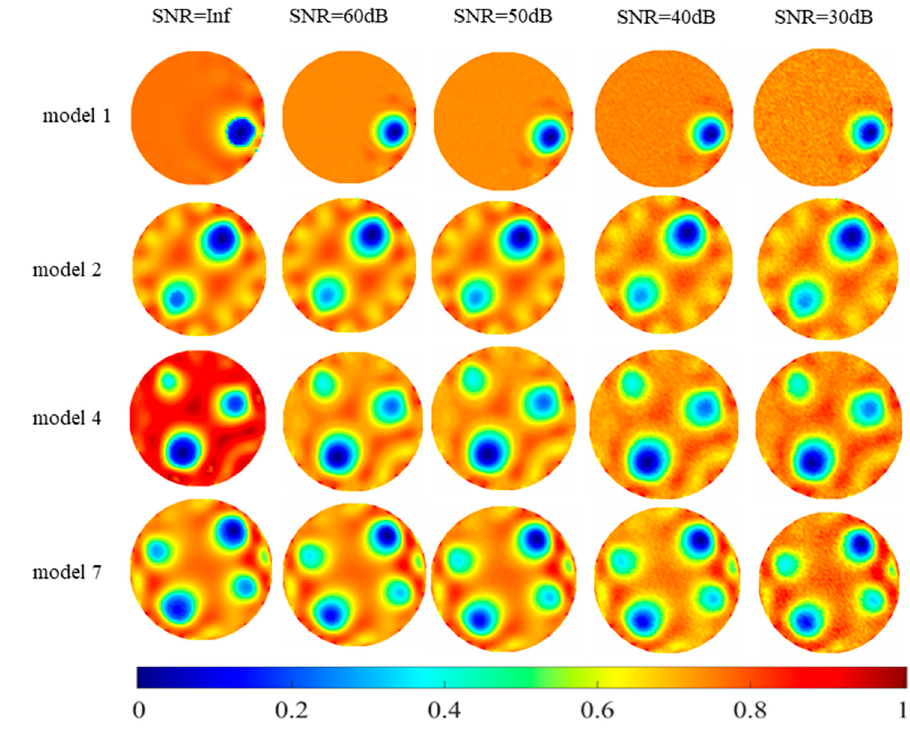
Figure 5. Image reconstruction results of noise experiment.